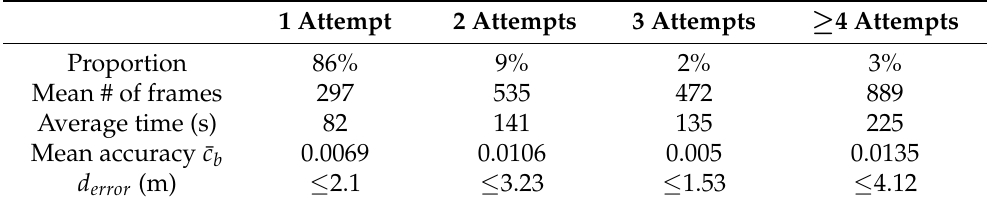
Table 4. Statistical results of 100 Monte Carlo runs, where aerial image and reference image are with different sun illumination